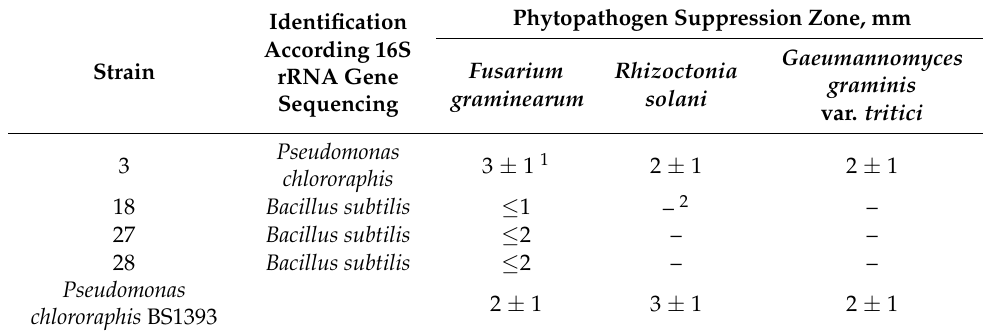
Table 1. Antagonistic activity of the soil strains against phytopathogenic fungi.